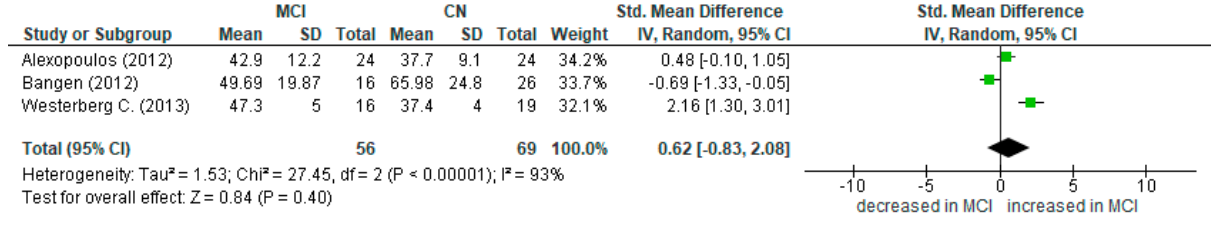
Figure 4. Hippocampus: mild cognitive impairment vs. cognitively normal (Alexopoulos P. (2012) [33], Dai W. (2009) [41], Dolui S (2020). [43], Glodzik L. (2011) [45], Huang Q. (2019) [47], Li D. (2020) [50], Westerberg C. (2013) [55], Wierenga C.E. (2012) [56]). There is no statistical difference in cerebral perfusion between MCI and CN.